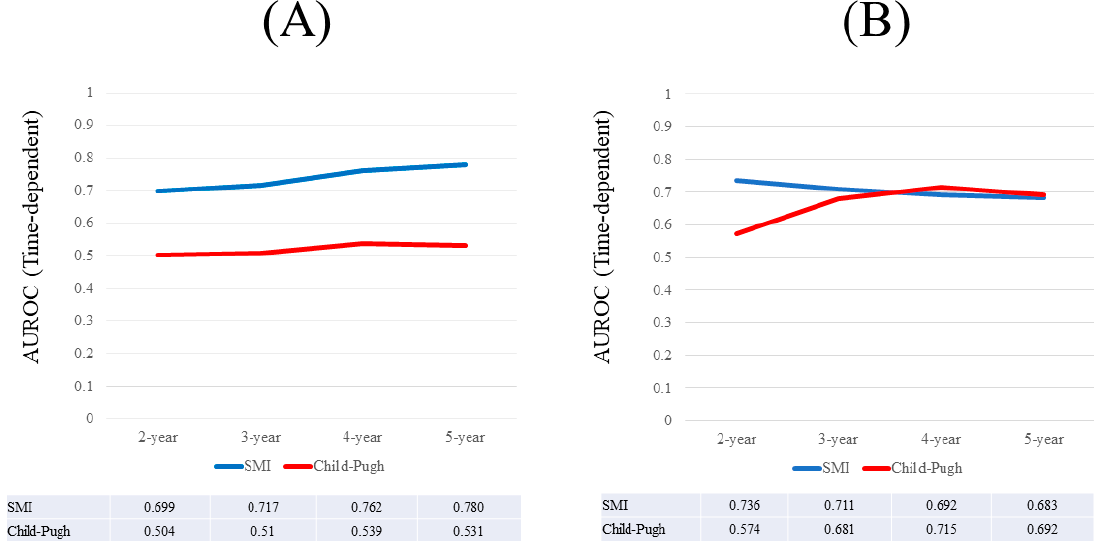
Figure 6. ( A ) Results for time-dependent ROC analyses at two-, three-, four-, and five-years of SMI and Child-Pugh score for male Child-Pugh B or C patients; ( B ) Results for time-dependent ROC analyses at two-, three-, four-, and five-years of SMI and Child-Pugh scores for female Child-Pugh B or C patients. ROC; receiver operating characteristics, AUROC; area under the ROC, SMI; skeletal muscle mass index.